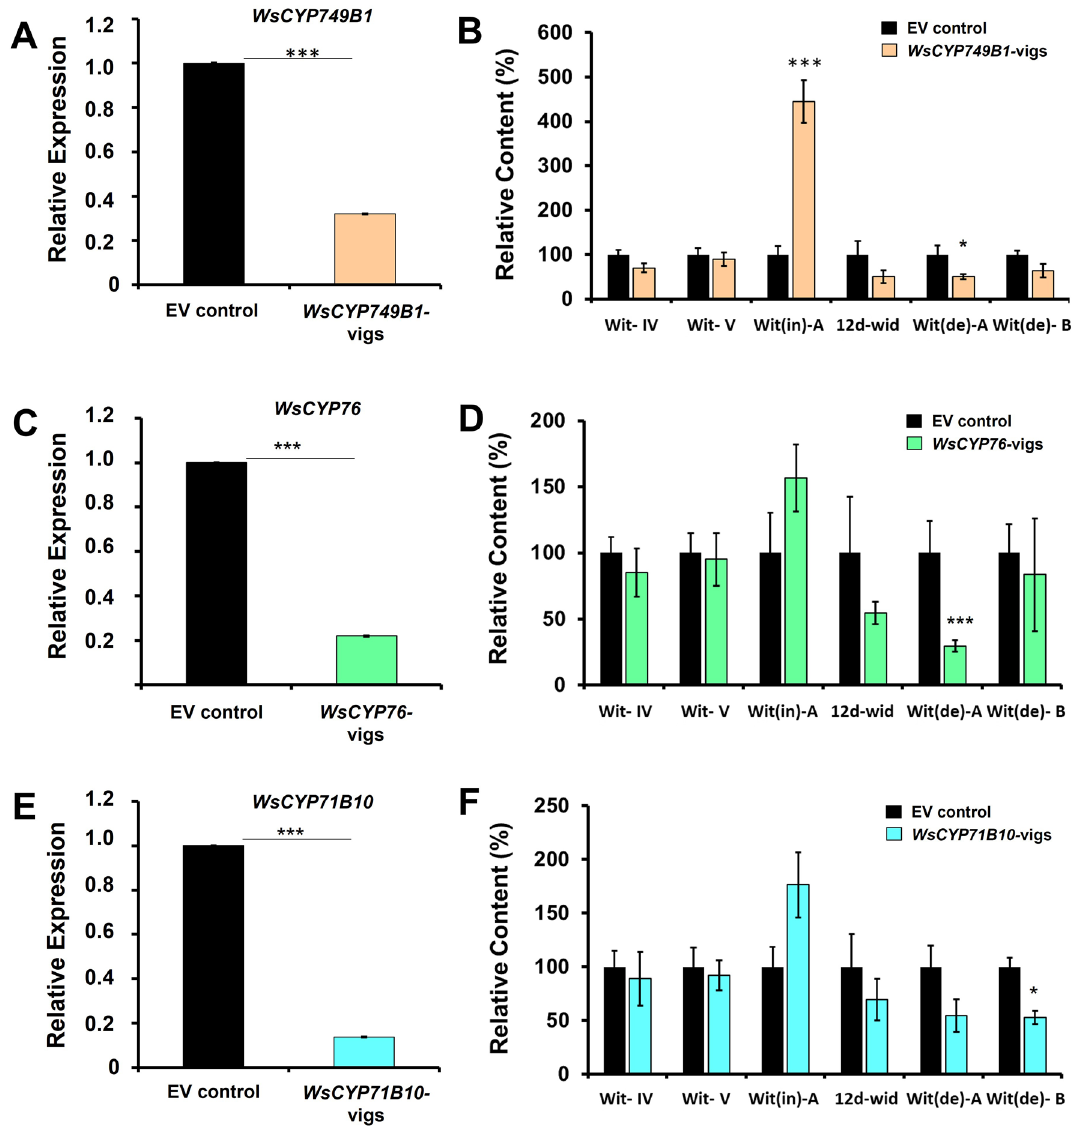
Figure 3. VIGS of WsCYP450 genes and its effect on withanolides profile. Relative expression of WsCYP450 genes ( A , C , E ) and contents of individual withanolides ( B , D , F ) in W. somnifera leaves infected with VIGS constructs and empty vector (EV) control samples. Expression levels of WsCYP450s were normalized to 18S rRNA and are represented as expression relative to EV control that was set to 1. Quantity of withanolides is expressed relative to EV and peak area was determined after normalization with internal standard, catharanthine. Wit-IV, withanoside IV; Wit-V, withanoside V; Wit(de)-A, withanolide A; Wit(de)-B, withanolide B; Wit(in)-A, withaferin A; 12d-wit, 12-deoxywithastramonolide. Error bars show mean ± SE of at least three independent experiments. Statistical significance represented as * p < 0.033, ** p < 0.002, *** p < 0.001, a significant